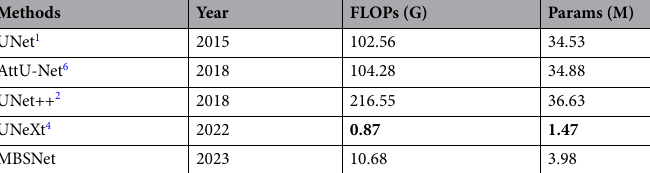
Table 2. Comparison of computational complexity and number of parameters between MBSNet and each comparison model. Significant values are in [bold].